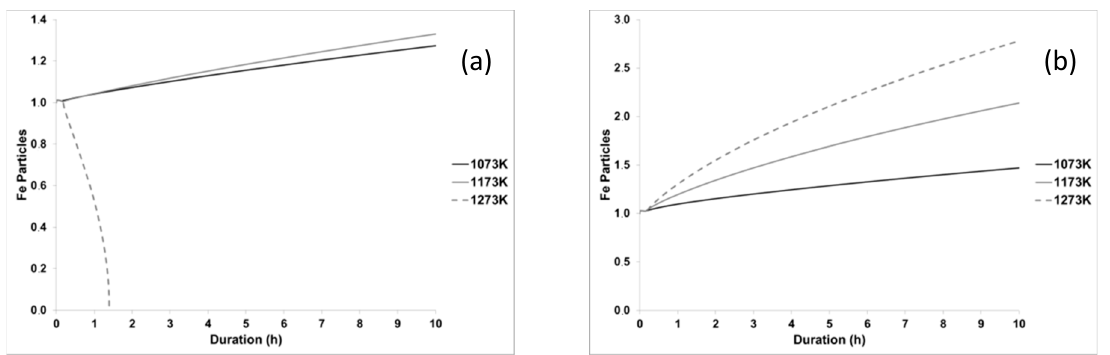
Figure 7. Simulation results of homogenization for Fe particles tested at various temperatures for ( a ) depleted copper matrix in Fe and P ( b ) enriched copper matrix in Fe and P.